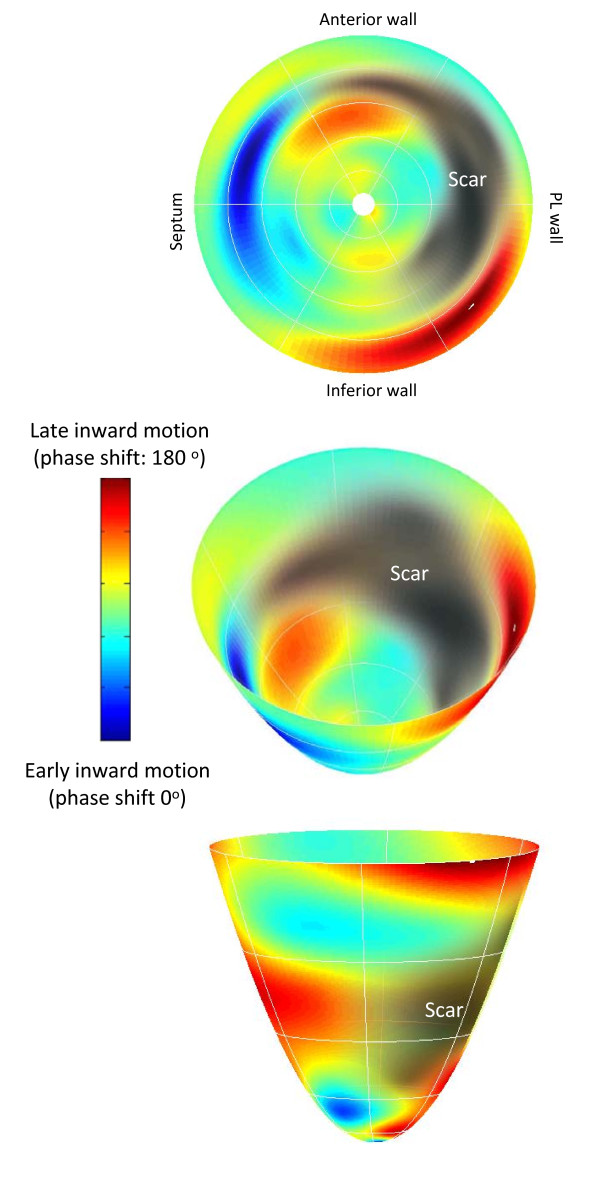
Spatial distribution of endocardial wall motion in heart failure. The color-encoded regional delay of radial inward motion is mapped onto a bull's eye map and three dimensional surfaces of the left ventricular model, pictured from above (middle figure) and below (bottom figure). Timing of radial inward motion is expressed as a phase delay ranging from zero to 180°. A phase delay of zero represents early ventricular motion concordant with initial electrical ventricular activation and is colour coded blue, while a phase delay of 180° denotes diastolic inward motion and is colour coded red. The posterolateral scar, shown in grey-black and imaged originally using late gadolinium-enhancement, is superimposed on the endocardial wall motion map. In the figure, the left ventricular septum is activated early in systole and the inferior wall close to the postero-lateral scar shows abnormal diastolic radial inward motion. Note the patchy distribution of wall motion throughout the left ventricle